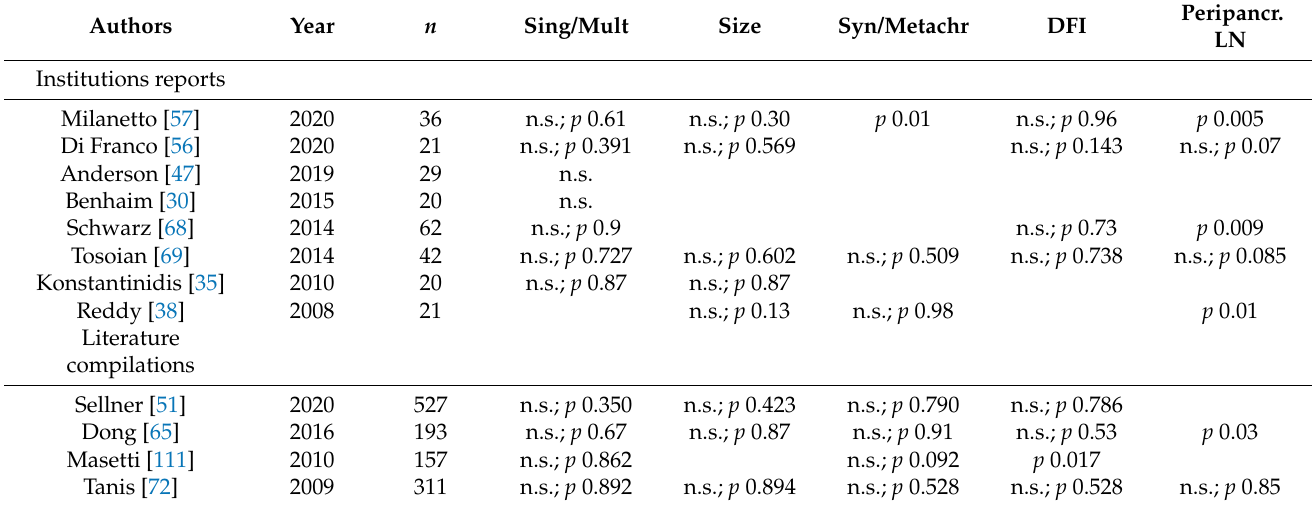
Table 2. isPMRCC—Impact of potential risk factors for overall survival (OS) after pancreatic surgery; ( n = number of patients; Sing/Mult = singular vs. multiple pancreatic metastases (PM), Syn/Metachr = synchronous vs. metachronous; DFI = disease-free interval between RCC and PM surgery; Peripancr. LN = peripancreatic lymph nodes; n.s. = non- significant; p = p